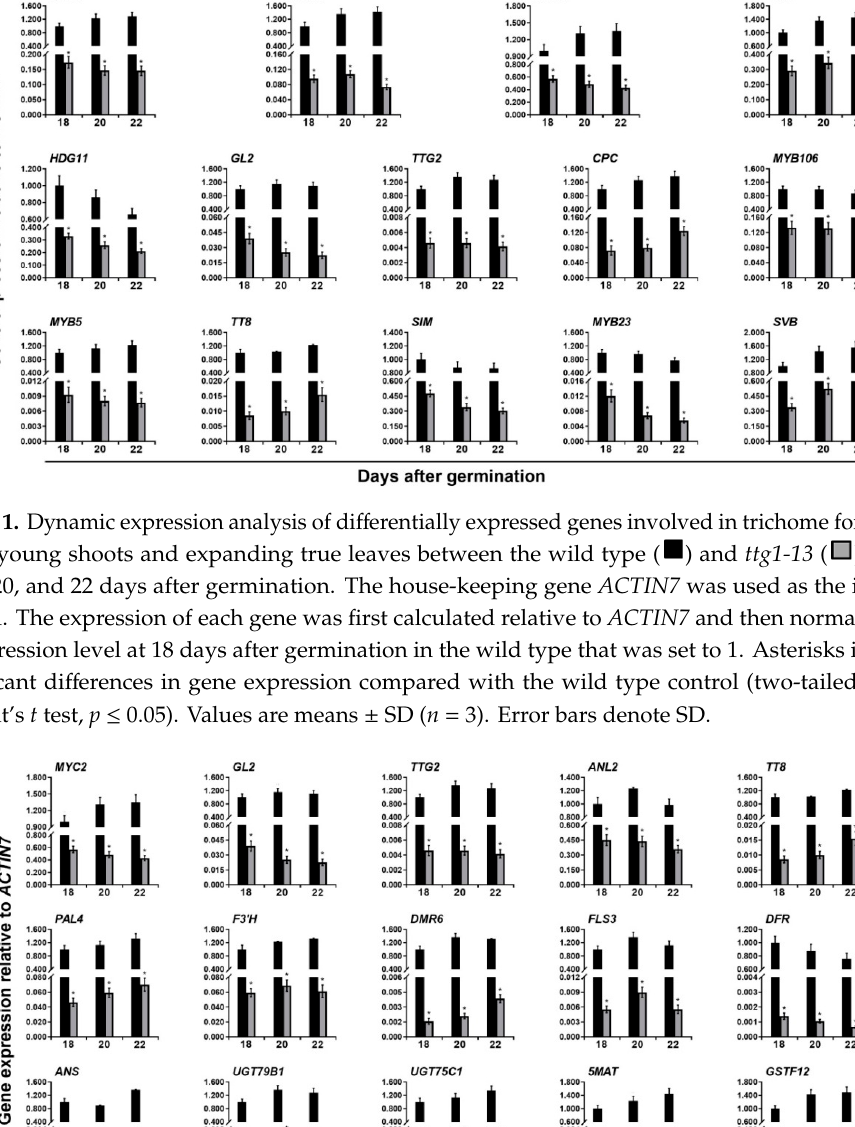
Figure 2. Dynamic expression analysis of downregulated genes involved in flavonoid biosynthesis in the young shoots and expanding true leaves between the wild type and ttg1-13 plants at 18, 20, and 22 days after germination. The house-keeping gene ACTIN7 was used as the internal control. The expression of each gene was first calculated relative to ACTIN7 and then normalized to its expression level at 18 days after germination in the wild type that was set to 1. Asterisks indicate significant differences in gene expression compared with the wild type control (two-tailed paired Student’s t test, p ≤ 0.05). Values are means ± SD ( n = 3). Error bars denote SD.